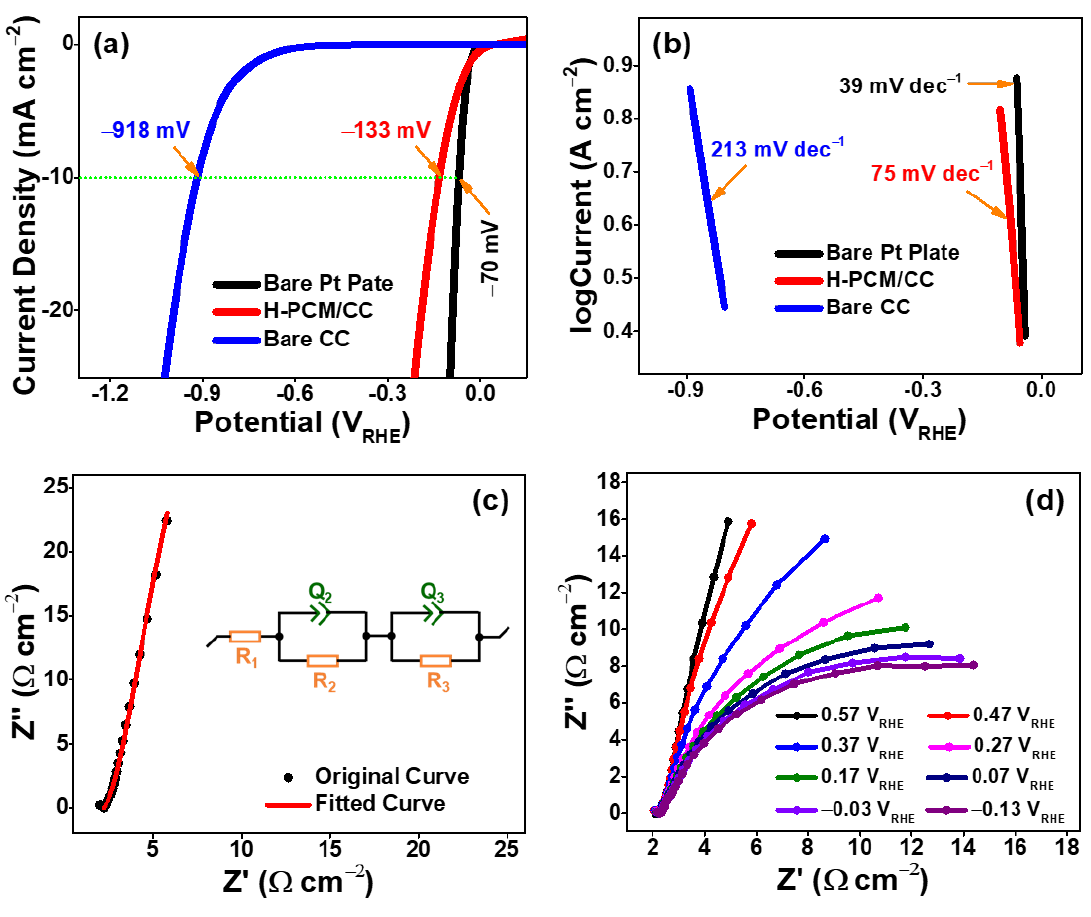
prolonging stability. Figure S6 shows the EIS Nyquist plots of synthesized H-PCM elec- Figure 5. Electro-catalytic studies of synthesized H-PCM, bare platinum plate, and bare carbon cloth trodes obtained before and after prolonged stability. The EIS Nyquist plots exhibit insig- Figure 5. Electro-catalytic studies of synthesized H-PCM, bare platinum plate, and bare carbon cloth electrodes in 0.5 M H 2 SO 4 aqueous solution towards HER under static atmosphere; ( a ) linear sweep electrodes in 0.5 M H 2 SO 4 aqueous solution towards HER under static atmosphere; ( a ) linear sweep voltammetry polarization curves at the scan rate of 10 mV s −1 , ( b ) Tafel plots, ( c ) EIS Nyquist plot voltammetry polarization curves at the scan rate of 10 mV s − 1 , ( b ) Tafel plots, ( c ) EIS Nyquist plot and suitable fitting with the equivalent circuit of H-PCM electrode recorded at open circuit poten- tial, and ( d ) EIS Nyquist plot of H-PCM electrode at different overpotentials. and suitable fitting with the equivalent circuit of H-PCM electrode recorded at open circuit potential, acidic medium. and ( d ) EIS Nyquist plot of H-PCM electrode at different overpotentials. The stability of the synthesized electrocatalyst is one of the essential criteria for the applicability of real-time applications. Hence, the long-term durability measurement of synthesized H-PCM is performed by the chronoamperometry method at a controlled po- tential of −0.15 V RHE, as shown in Figure 6a. The durability test was conducted in 0.5 M H 2 SO 4 aqueous solution for 24 h, and the retention rate of current density was maintained at nearly 100% compared to the initial current density, manifesting that the H-PCM was remarkably stable [64]. Nitrogen and sulfur-rich carbon materials showed remarkable cat- alytic activity toward HER with outstanding stability [65]. The linear sweep voltammetry polarization curve of the H-PCM/CC electrode was again recorded at the scan rate of 10 mV s −1 after the completion of the stability study. The obtained linear sweep voltammetry polarization curve was compared with the initial linear sweep voltammetry polarization curve of the H-PCM/CC electrode (Figure 6b). There is no significant difference in both linear sweep voltammetry polarization curves (before and after stability), authenticating that the synthesized H-PCM is greatly stable and could be a potential candidate as an electrocatalyst for HER in the acidic media. In addition, the EIS Nyquist plot of the syn- thesized H-PCM electrode measured at open circuit potential in 0.5 M H 2 SO 4 aqueous solution after the prolonged stability and obtained results were compared to before the